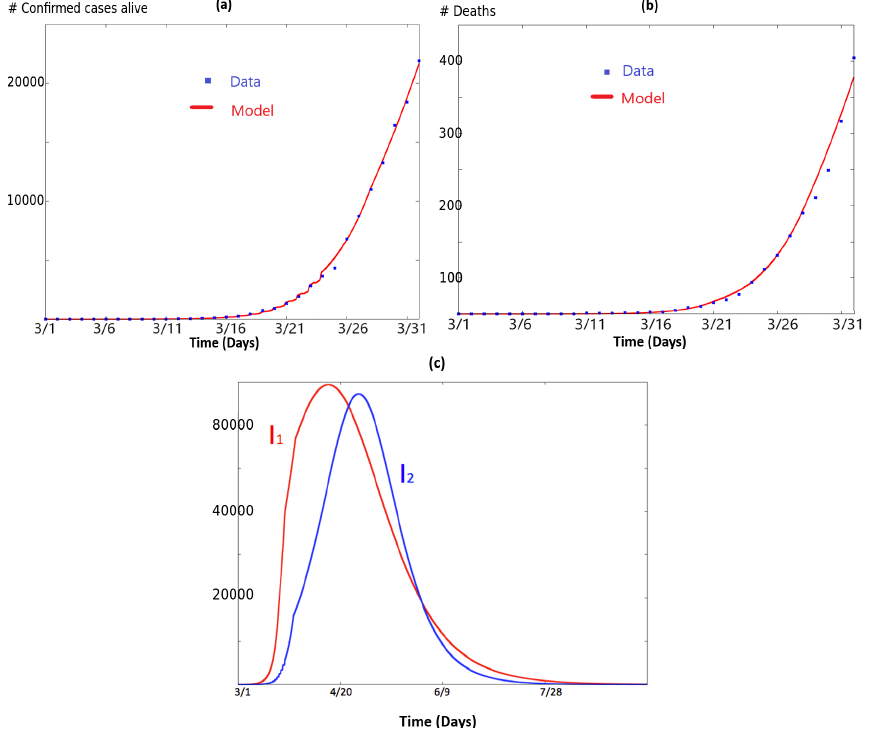
Figure 3. This figure illustrates the simulation of system (6) and how it fits the data. In ( a ), we have plotted the quantity 0.2 ( I 2 + R 2 ) as a function of time in red. Recall that, in the model I 2 + R 2 , represents the number of people in the population which has been infected by the virus and are still alive. The blue dots correspond to the data retrieved from [20] and plots the total number of infected minus the number (cid:82) t d 2 ( u ) I 2 ( u ) du ) as a function of time of total deaths. Analogously, in ( b ) we have plotted the quantity 0 in red. The blue dots correspond to the total number of deaths in NJ according with data retrieved from [20]. Panel ( c ) illustrates I 1 ( t ) and I 2 ( t ) , which represent respectively the infected in NY and